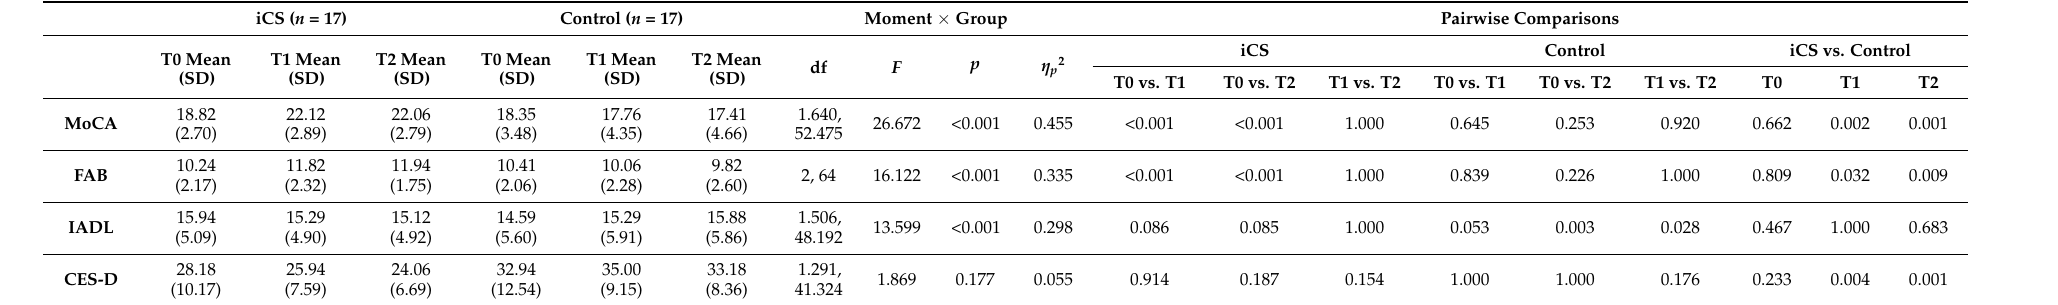
Table 2. Results of the repeated-measures ANOVA for MoCA, FAB, IADL, and CES-D scores. The results of the pairwise comparisons (Bonferroni correction) are given for iCS vs. the control group at baseline (T0), endpoint (T1), and follow-up (T2) assessments, as well as the results of the pairwise comparisons (Bonferroni correction) for iCS and control groups (T0 vs. T1, T0 vs. T2, and T1 vs.